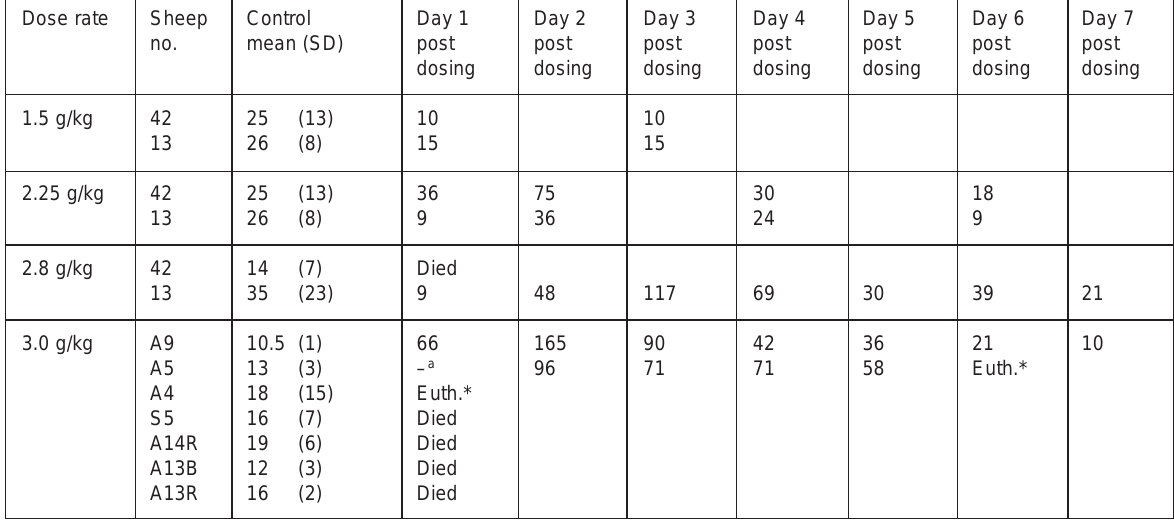
TABLE 6 Urine gamma glutamyltransferase (GGT) concentrations (units/ l ) in sheep—control values and values following dosing with Nolletia gariepina Dose rate